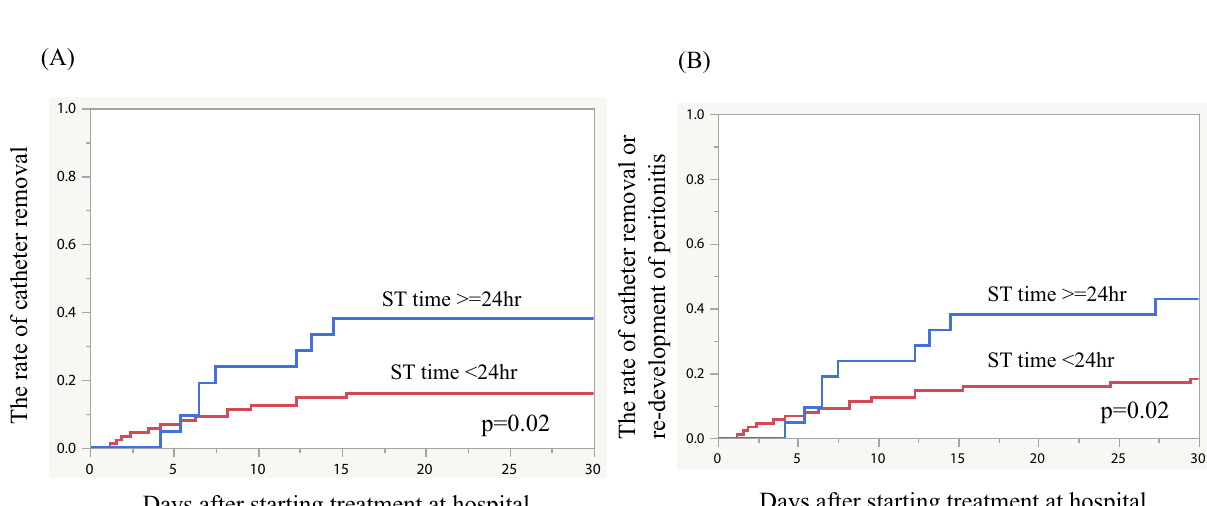
Figure 2. Kaplan–Meier analysis for the rate of catheter removal and relapse/recurrence of peritonitis during 1 month from initiation of treatment. Rate of catheter removal ( A ) and a composite outcome of catheter removal or relapse/recurrence of peritonitis ( B ) during 1 month from initiation of treatment were significantly higher in the ST time ≥ 24 h group compared with the ST time < 24 h group ( p = 0.02,